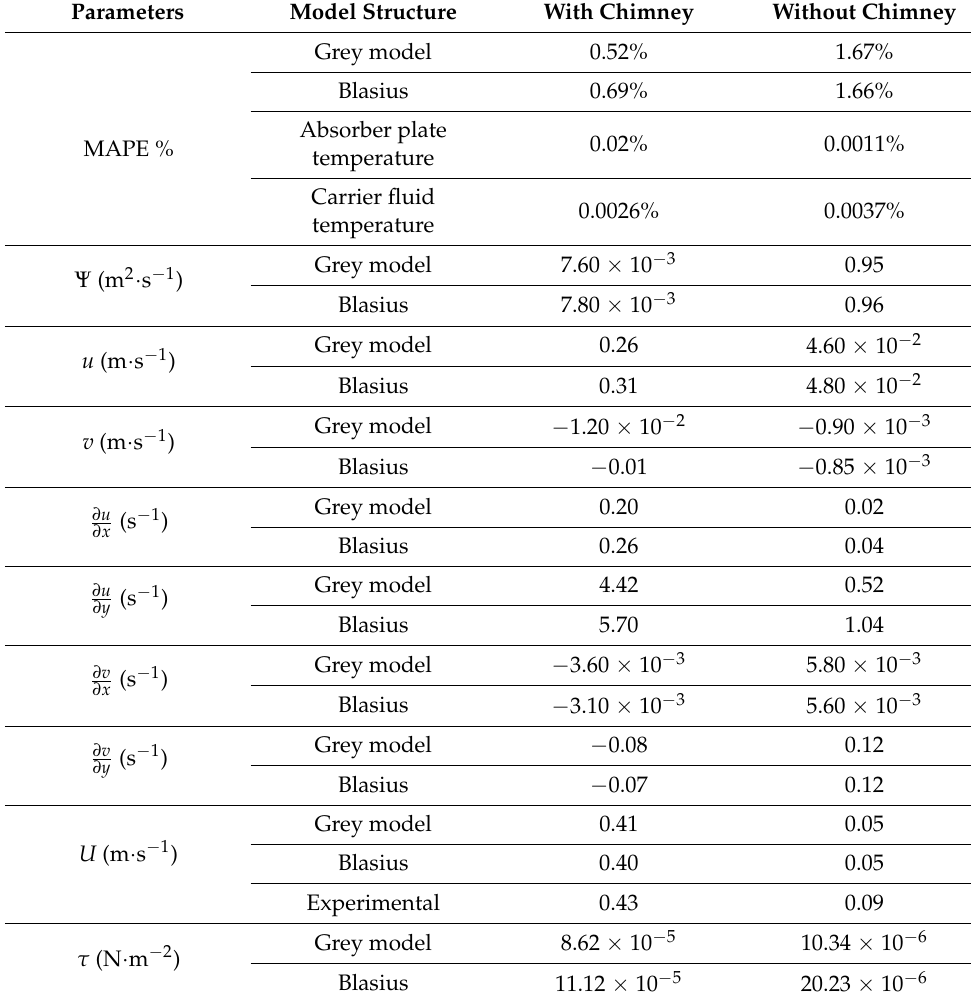
Table 4. Parametric information about the grey and analytical